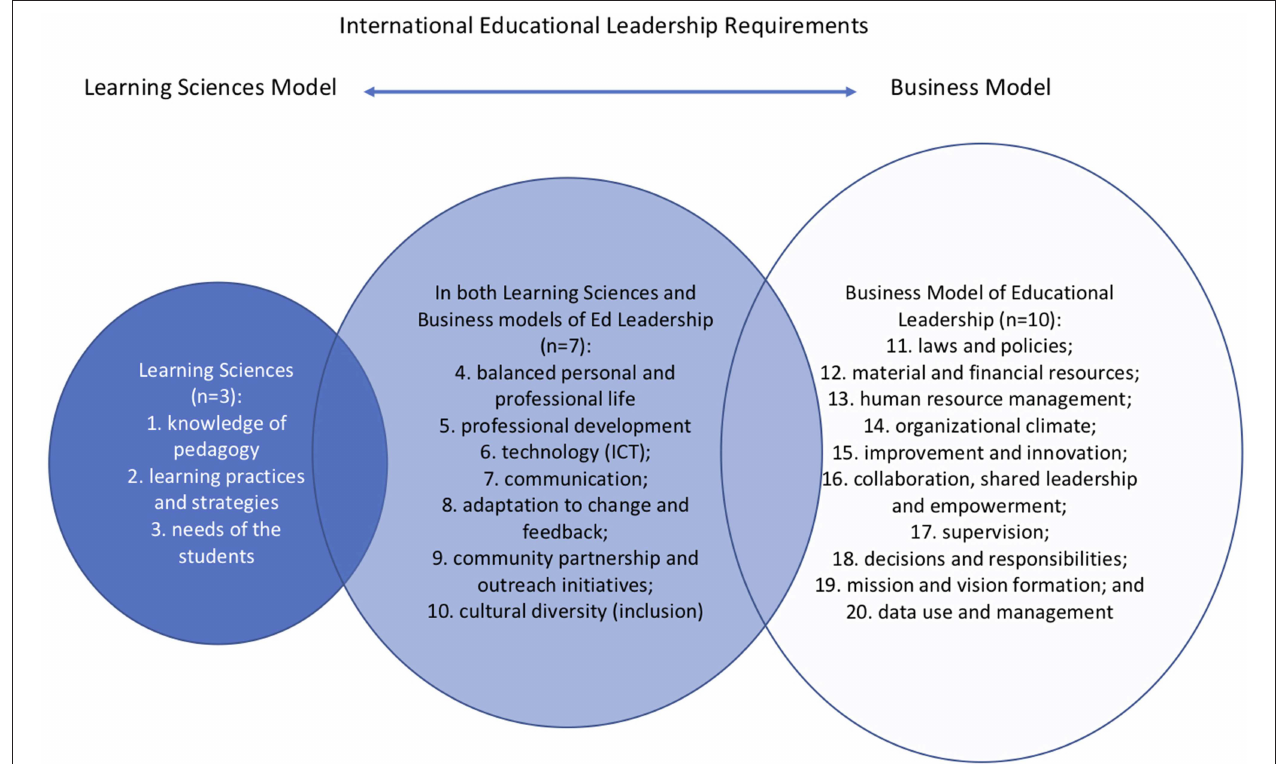
FIGURE 1 | Educational leadership